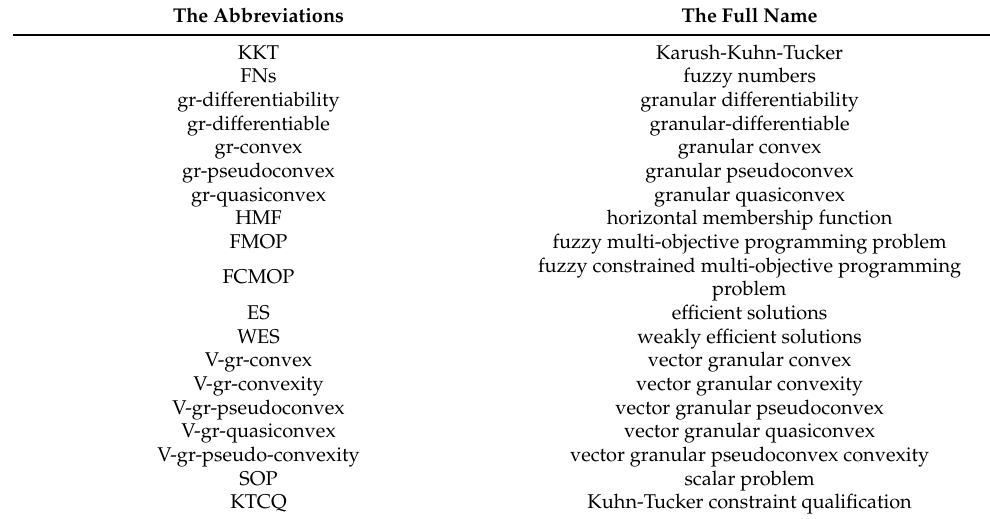
Table 1. The abbreviations have been used in this